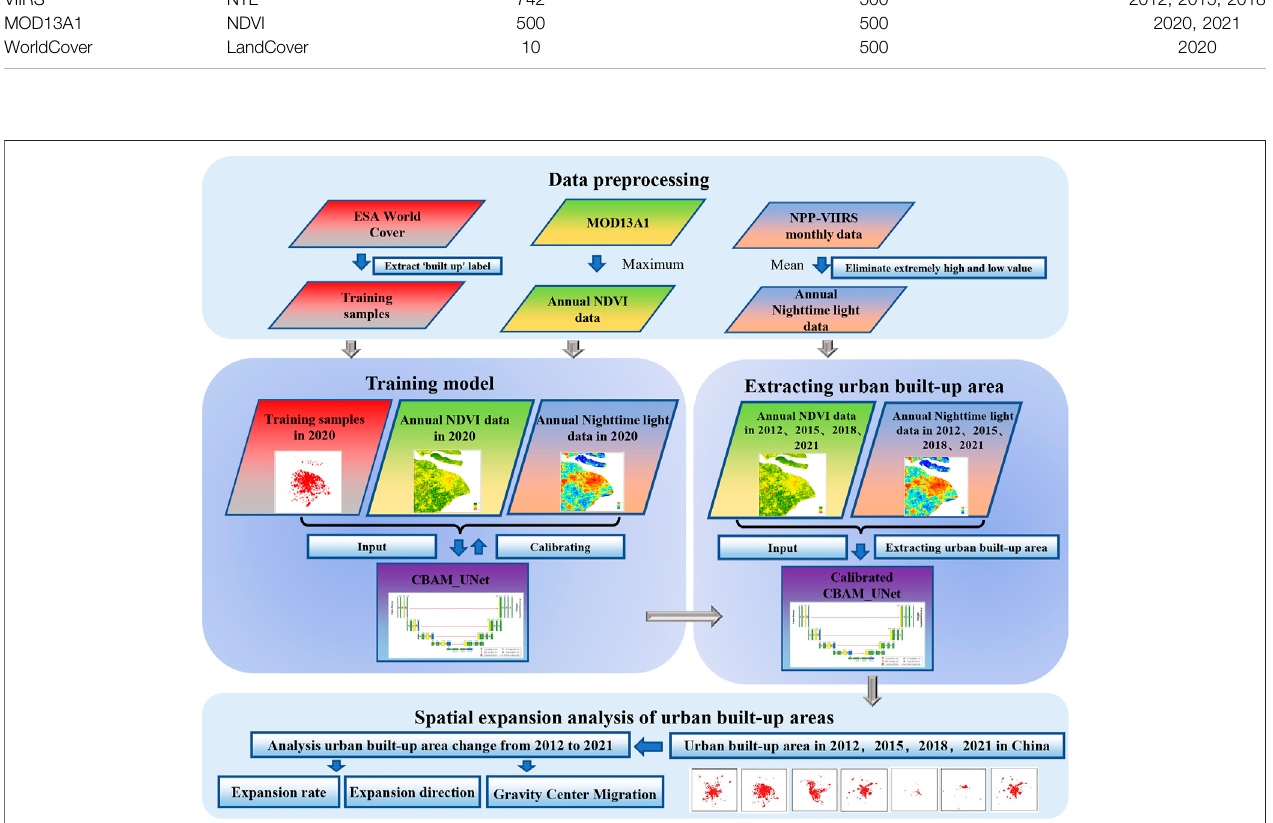
FIGURE 1 | Overview of the work fl